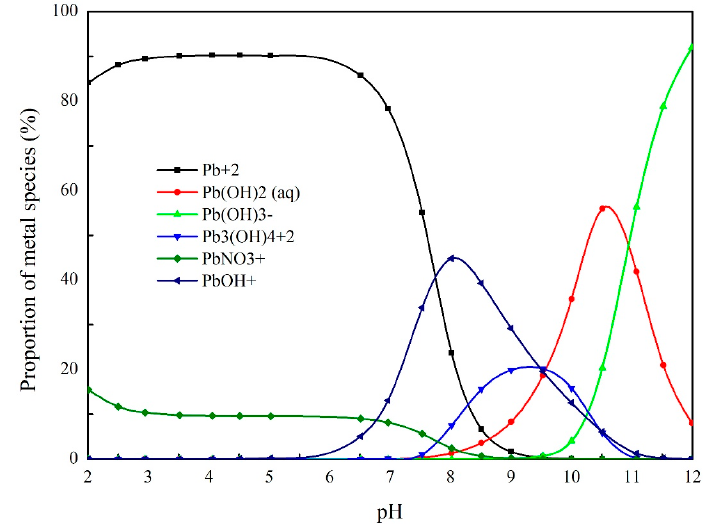
Figure 8. Effect of pH values on the aqueous speciation of lead in 0.01 M NaNO 3 .